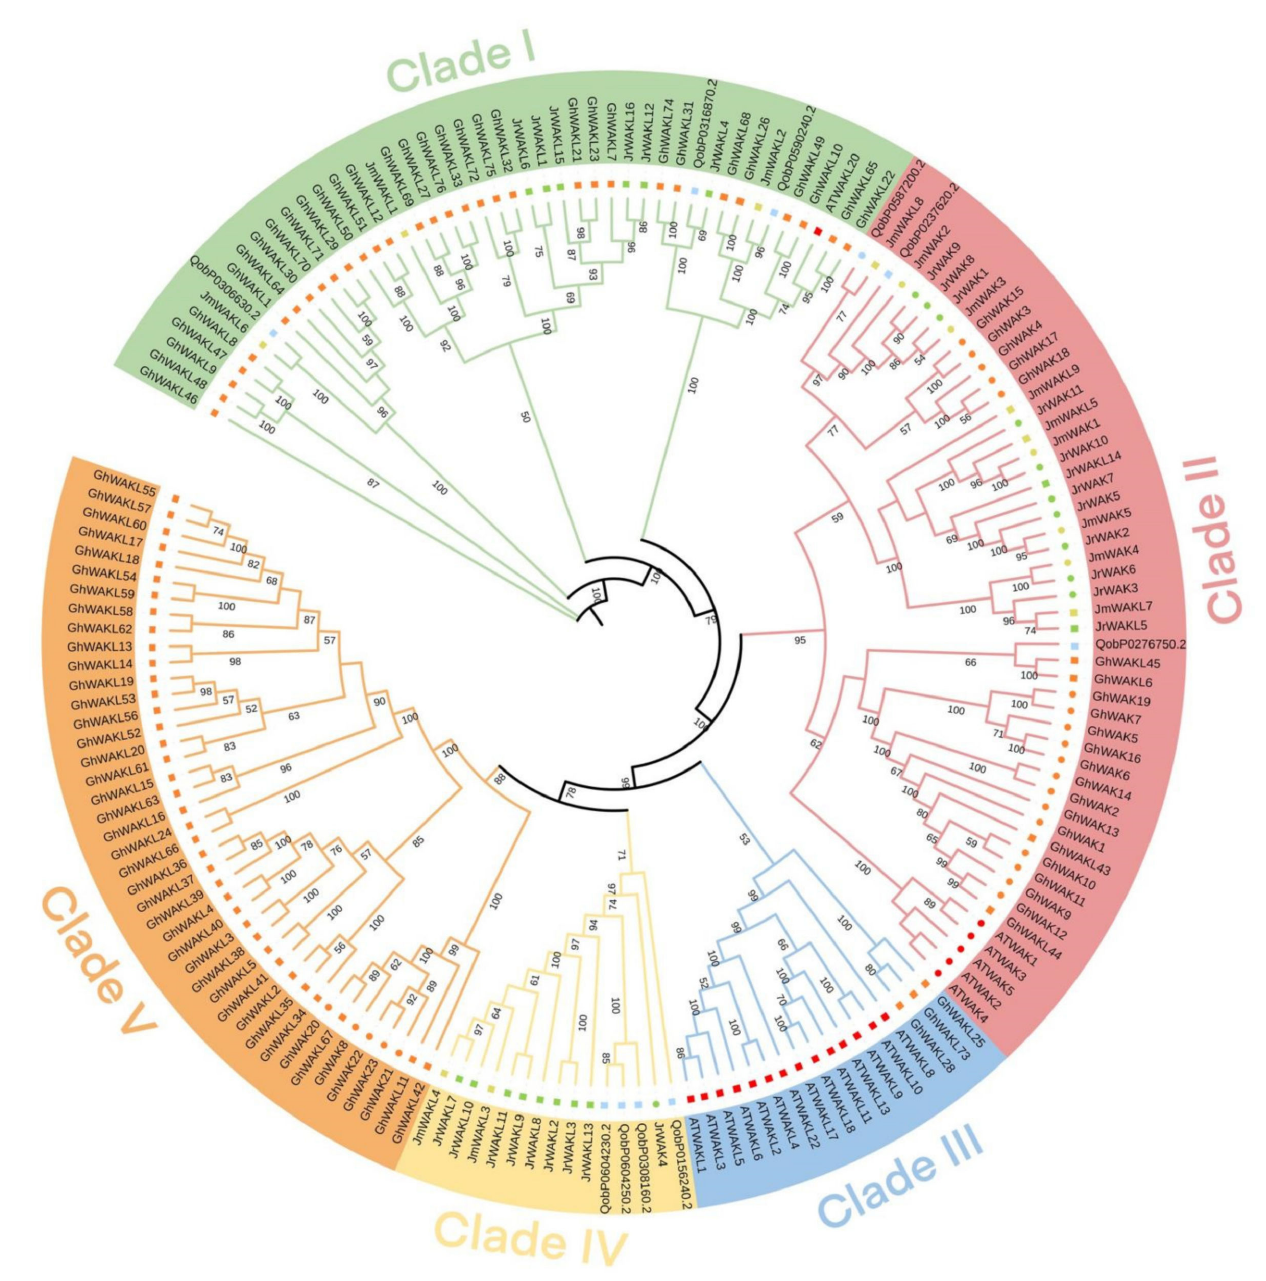
Figure 1. The Maximum Likelihood phylogenetic tree (ML) of WAK/WAKL proteins of Arabidopsis thaliana , Gossypium hirsutum , Quercus robur , Juglans regia and Juglans mandshurica . Circles and squares represented WAKs and WAKLs, respectively. Red, orange, blue, green and yellow represented WAK/WAKLs of A. thaliana , G. hisutum , Q. robur , J. regia and J. mandshurica ,